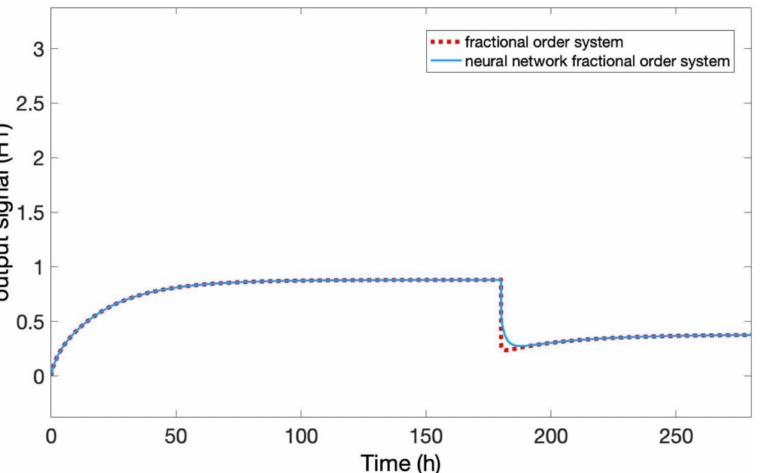
Figure 12. The proof of the proposed adaptive solution when a disturbance implies the β variation from 0.78 to 0.4 at t = 180 ( h ) .